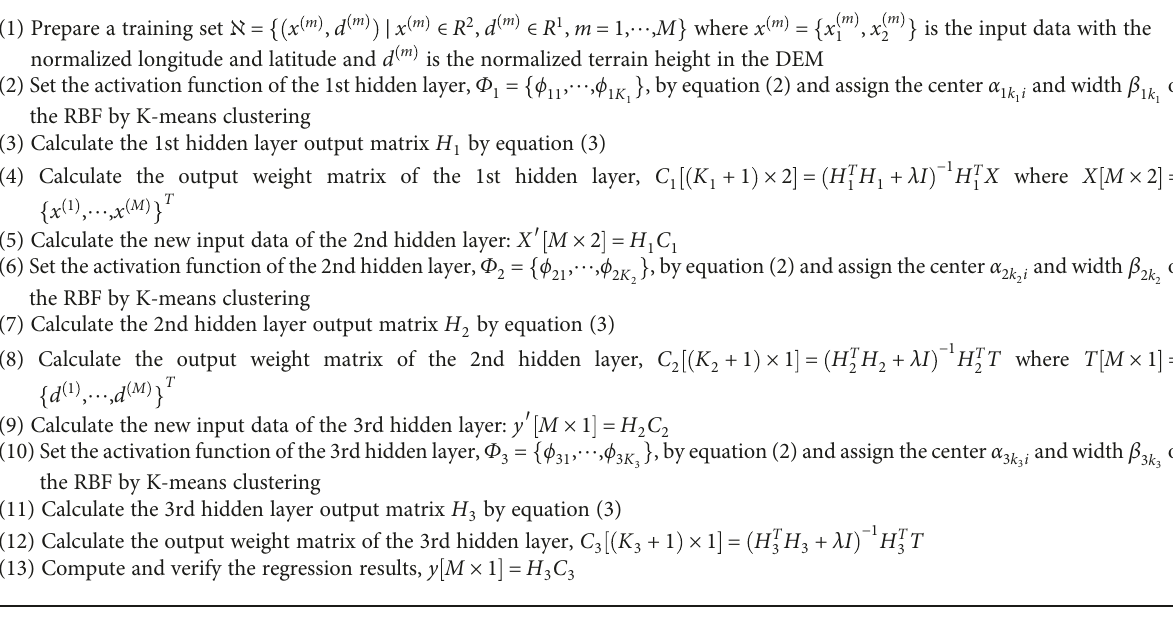
Algorithm 1: Proposed ML-RBF-ELM